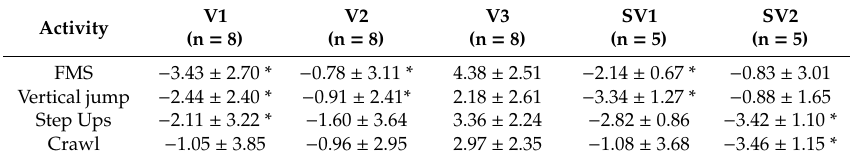
Table 3. Subjective results (mean ± SD) between the different assessments.